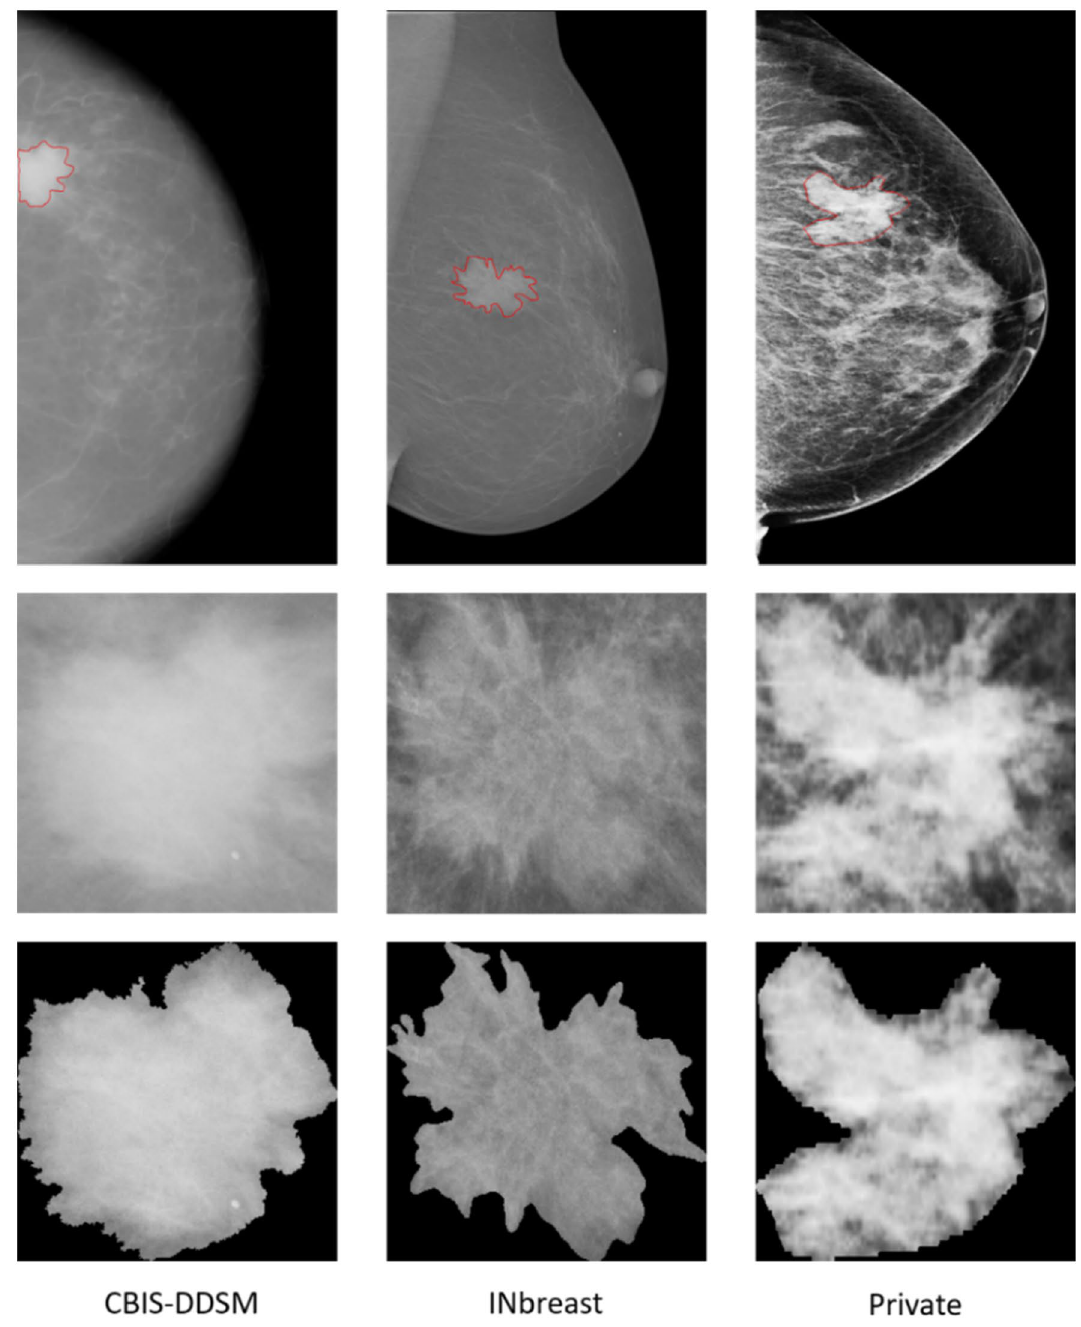
Figure 4. Samples of entire mammograms and ROI of a mass detected and segmented from different mammography datasets with ground-truth of location and contour of mass in